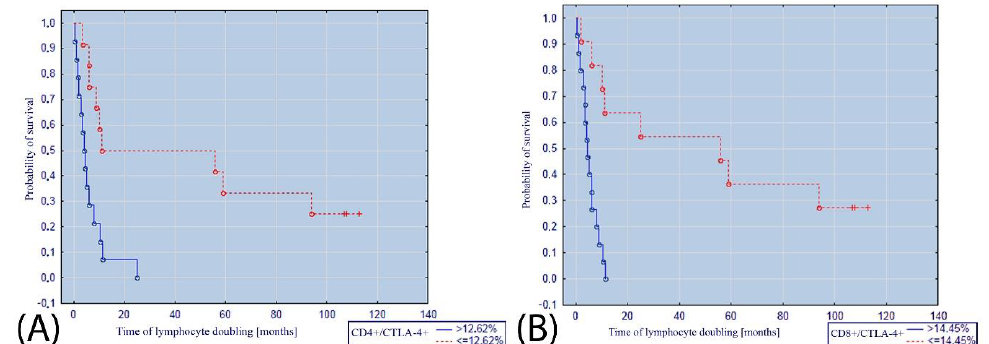
Figure 4. ( A ) Kaplan – Meier curve illustrating the probability of survival without doubling of the lymphocytosis depending on the percentage of ( A ) CD4+/CTLA-4+ lymphocytes; ( B ) CD8+/CTLA- 4+ lymphocytes.